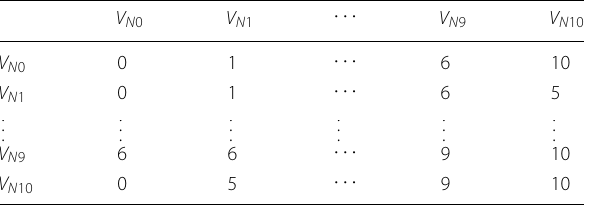
Table 3 Path matrix for N-Type